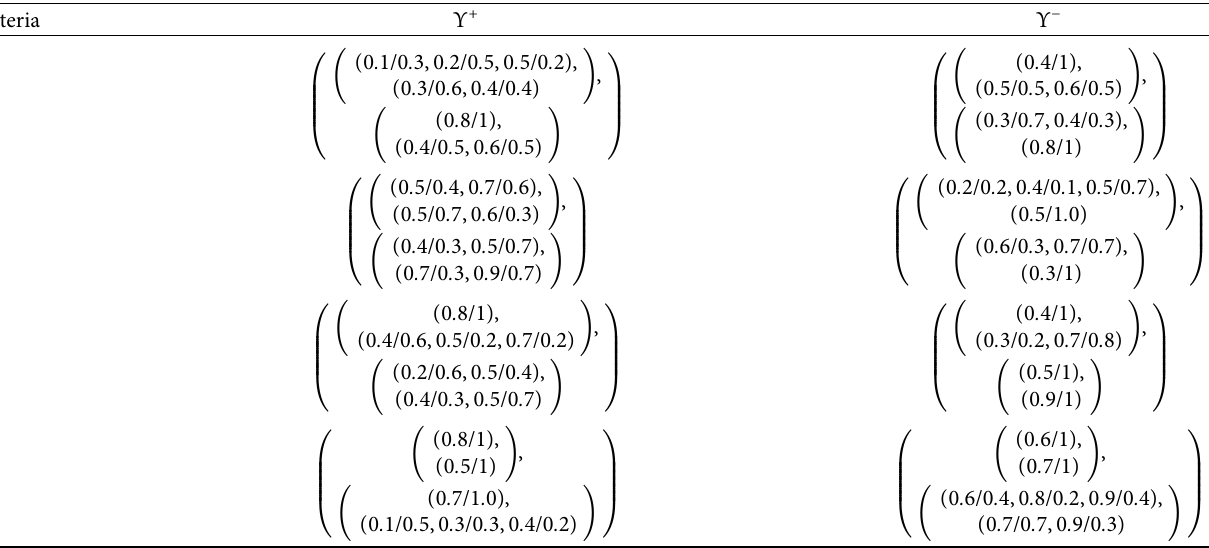
Table 16: Ideal solutions.